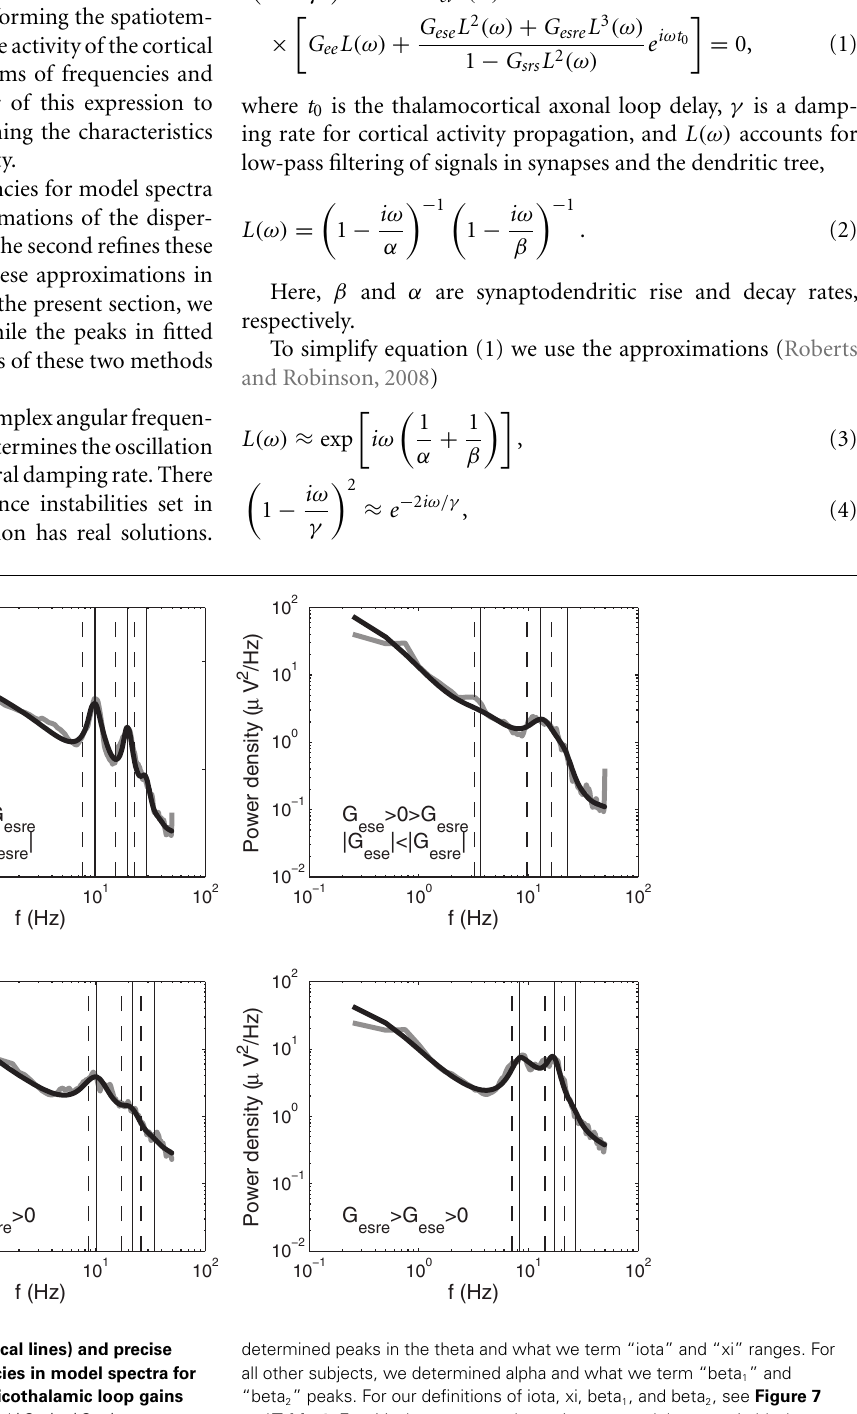
determined peaks in the theta and what we term “iota” and “xi” ranges. For all other subjects, we determined alpha and what we term “beta 1 ” and “beta 2 ” peaks. For our definitions of iota, xi, beta 1 , and beta 2 , see Figure 7 and Table 1 . Empirical spectra are shown in gray, model spectra in